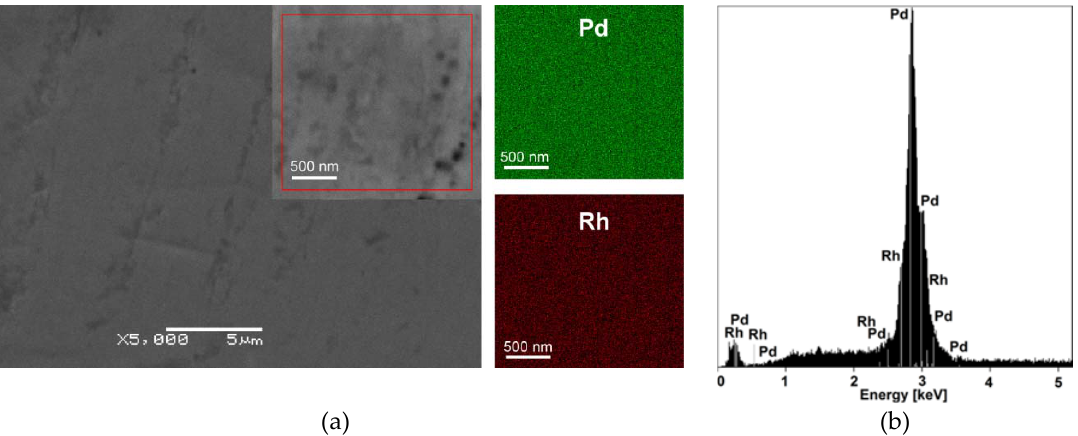
Figure 1. SEM image of the 50 µ m Pd 80 Rh 20 foil after annealing: ( a ) Bird’s-eye general view of the material (inset shows a detail of a selected micro-region) with the corresponding EDS map of Pd and Rh element distribution, obtained from the zoomed SEM image shown in the inset; ( b ) Energy dispersive spectrum of the Pd 80 Rh 20 foil in the micro ‐ region.